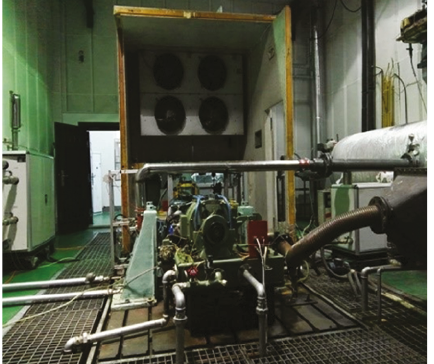
Figure 2: Simulation test bench of the gasoline engine for simulating high